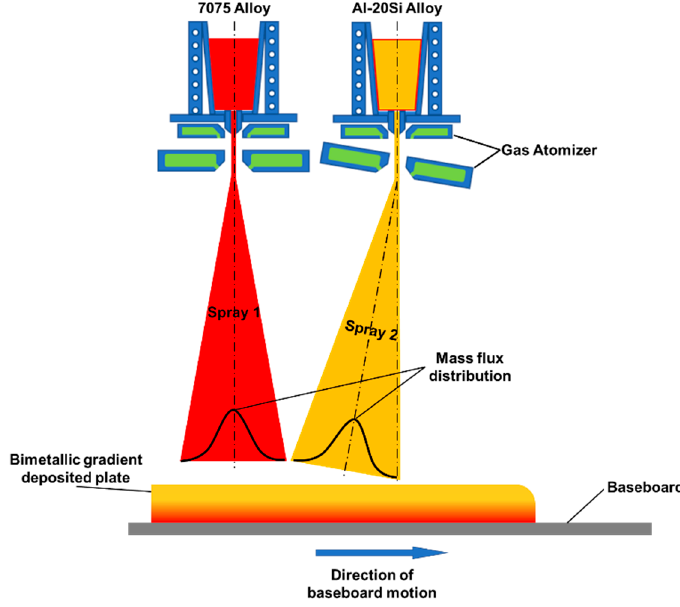
Figure 1. Schematic diagram of co ‐ spray forming process.